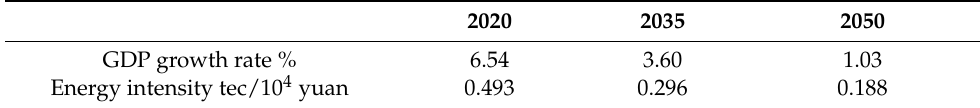
Table A4. GDP and energy intensity assumptions [33].